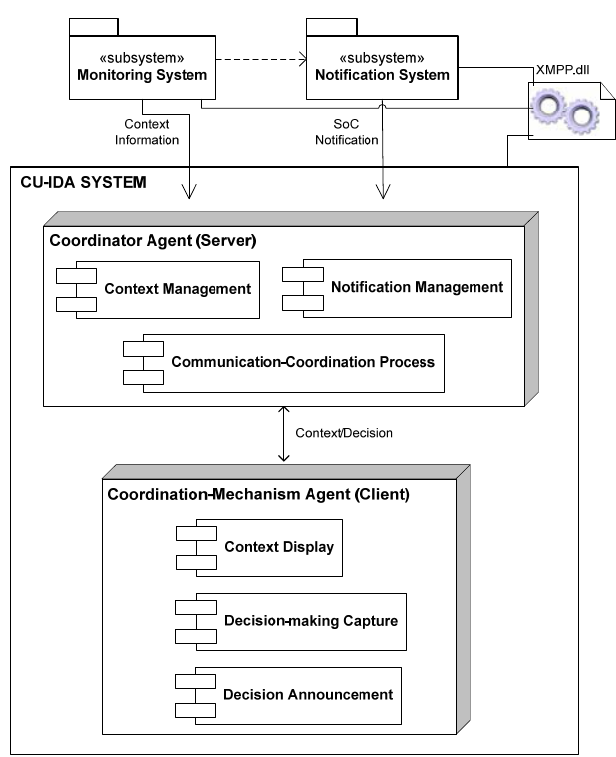
Figure 16. Architecture of the CU-IDA System.